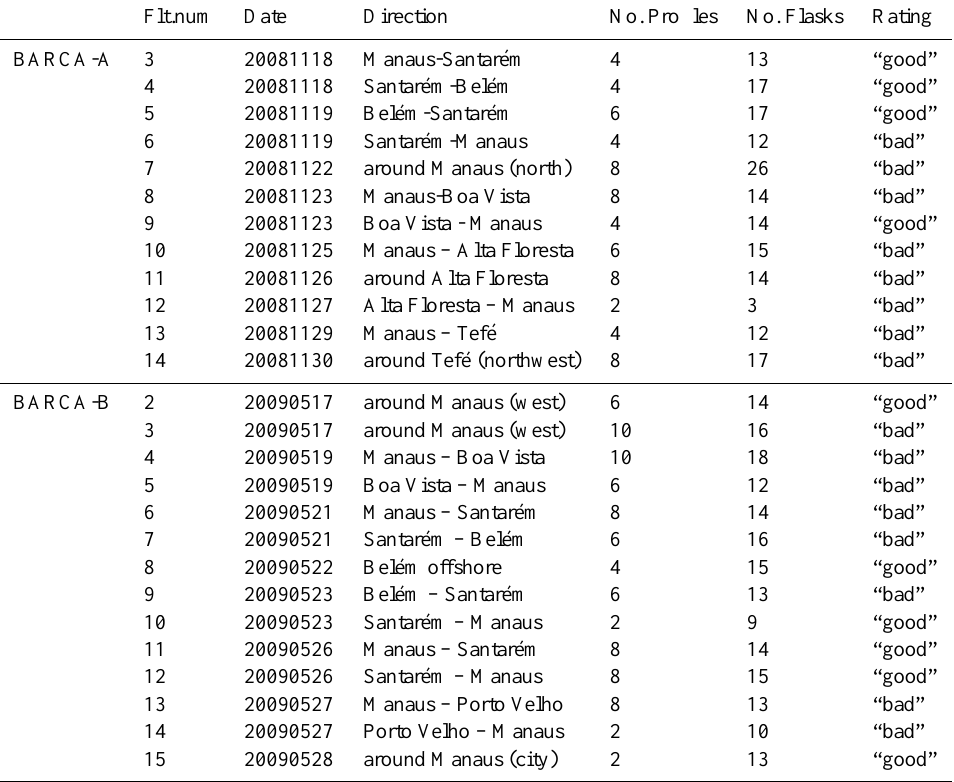
Table 4. Overview over all flights conducted during BARCA-A and BARCA-B indicated with their flight number (Flt.num), the date of each flight (Date), the flight origin and destination (direction), the number of vertical profiles flown (No. Profiles), the number of flasks sampled (No. Flasks) and rating as “good” or “bad” flights